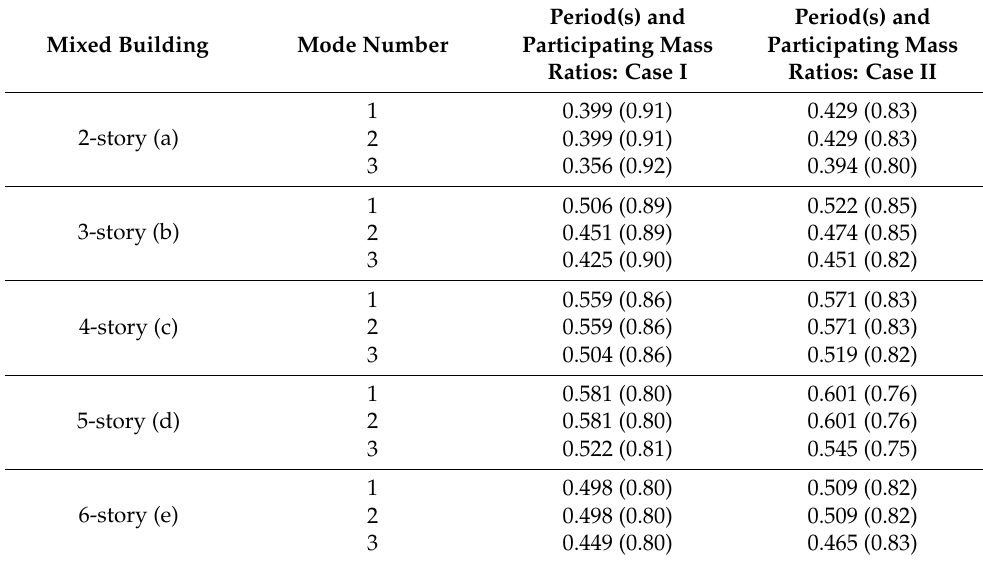
Table 2. Modal properties of the mixed buildings of Figure 1.